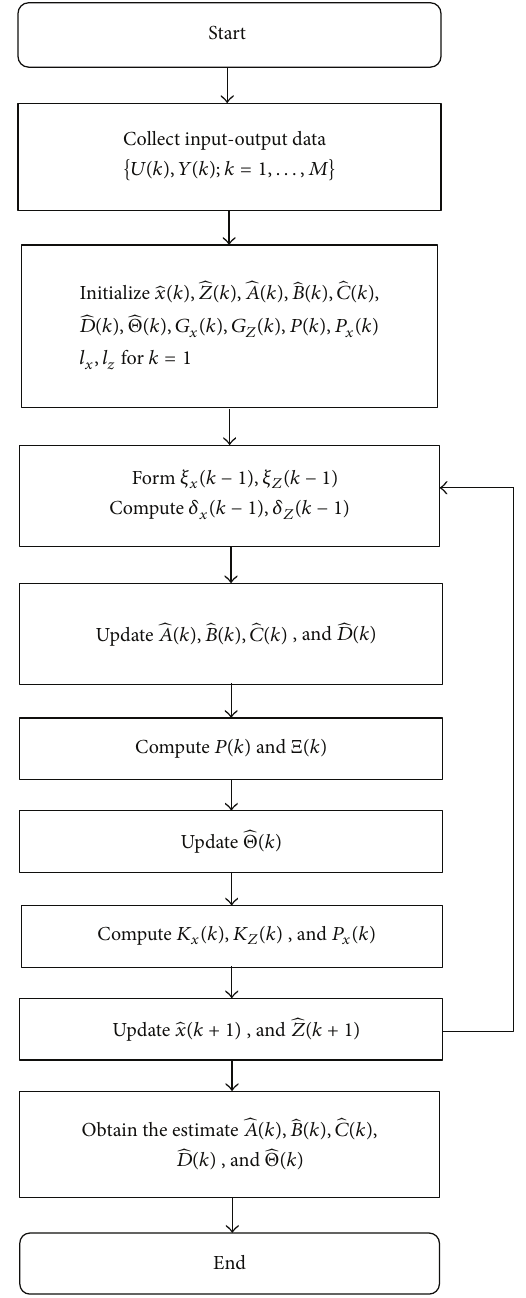
Figure 2: Flowchart for recursive estimation of MIMO Wiener